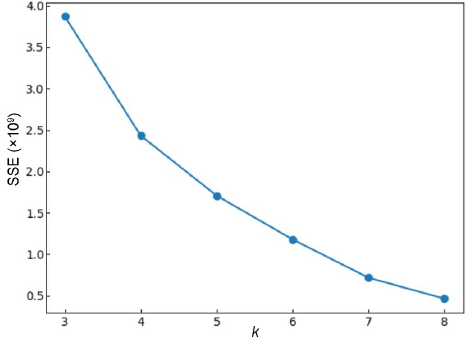
Fig. 6 K -Means clustering the sum of squared errors of different k